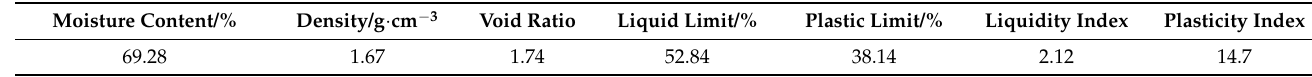
Table 1. Basic physical indicators of clay.